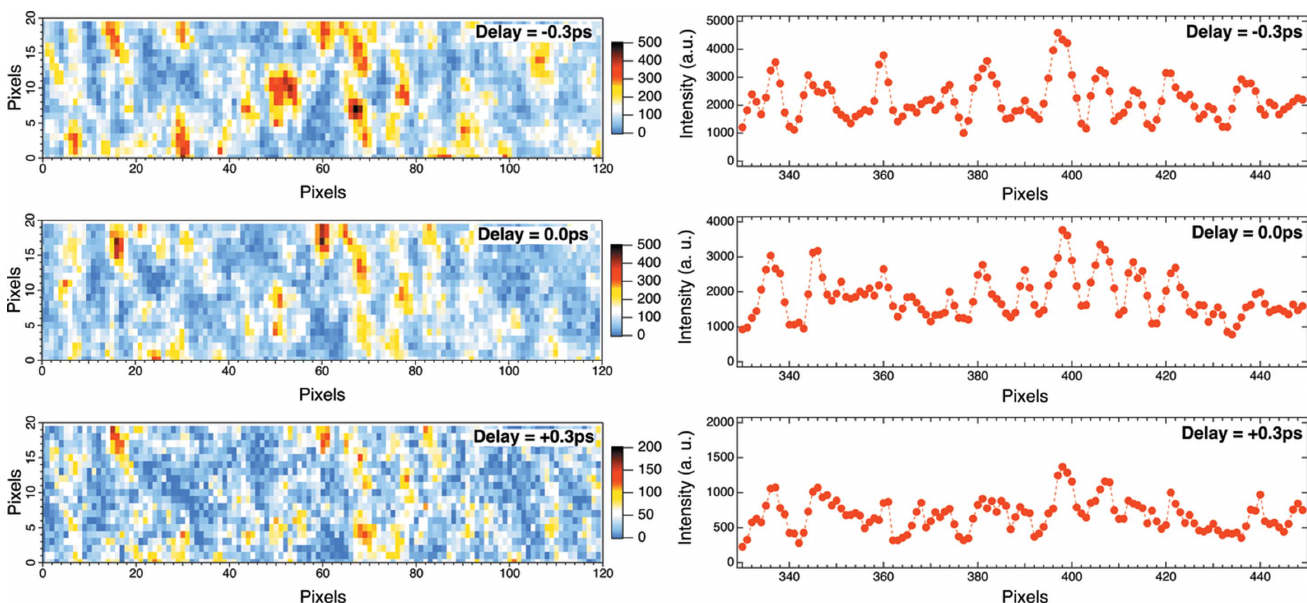
Figure 6 (Left) Zoom on the magnetic Bragg peak intensity for speckles visibility and (right) the associated line plots resulting from the summation over the lines for each